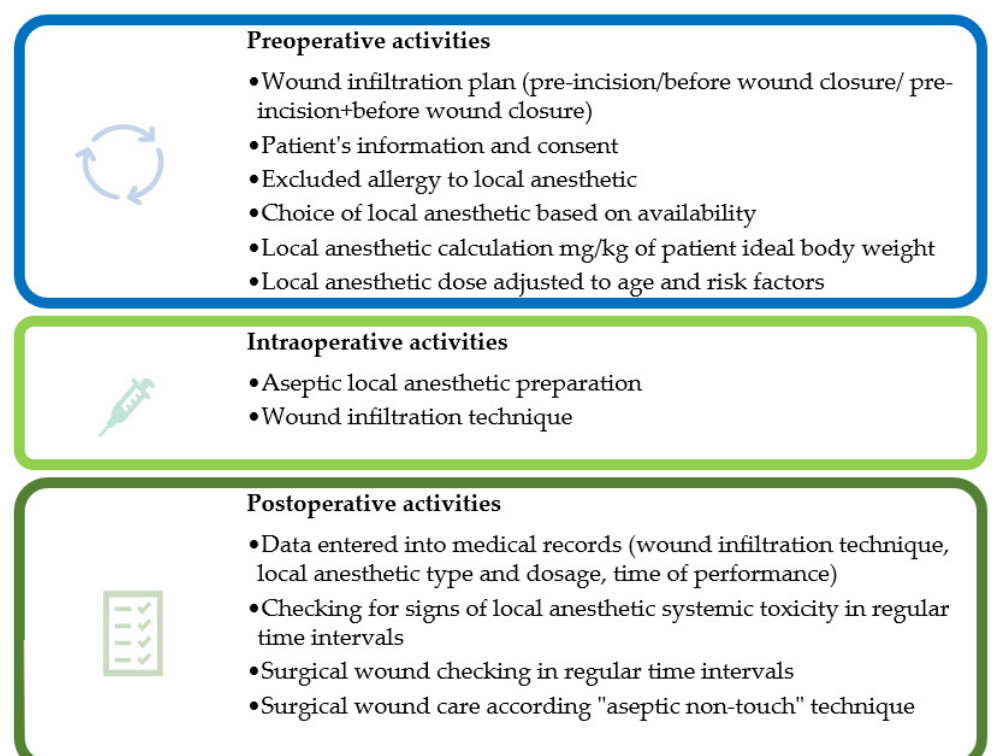
Figure 3. Check ‐ list for single ‐ shot wound infiltration planning, performance, and follow ‐ up. Figure 3. Check-list for single-shot wound infiltration planning, performance, and